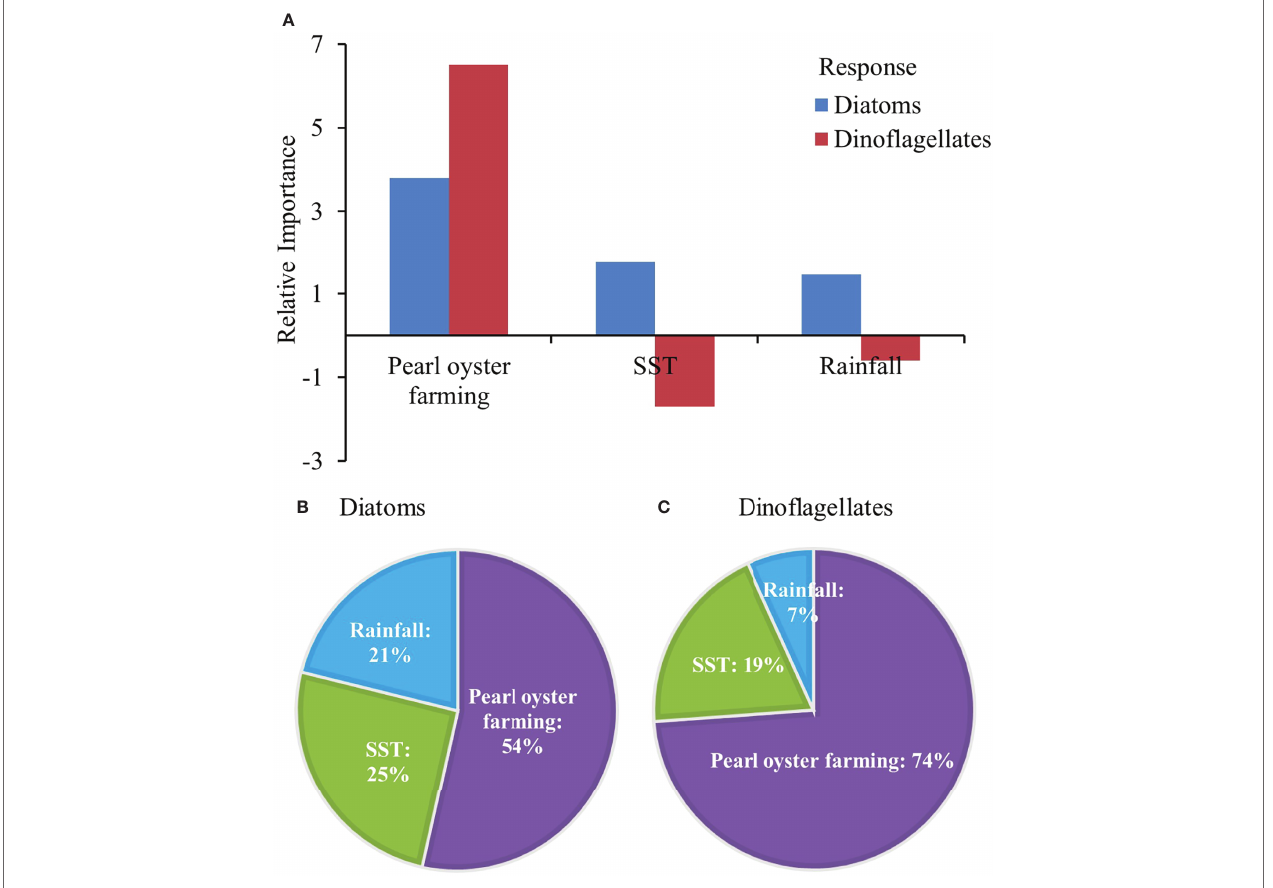
FIGURE 3 | Bar (A) and pie plots (B, C) representing the relative importance of environmental factors for diatoms and dinoflagellates estimated from ANN weights through the ‘Olden’ method. The pie plots are calculated by the absolute values of the relative importance of environmental